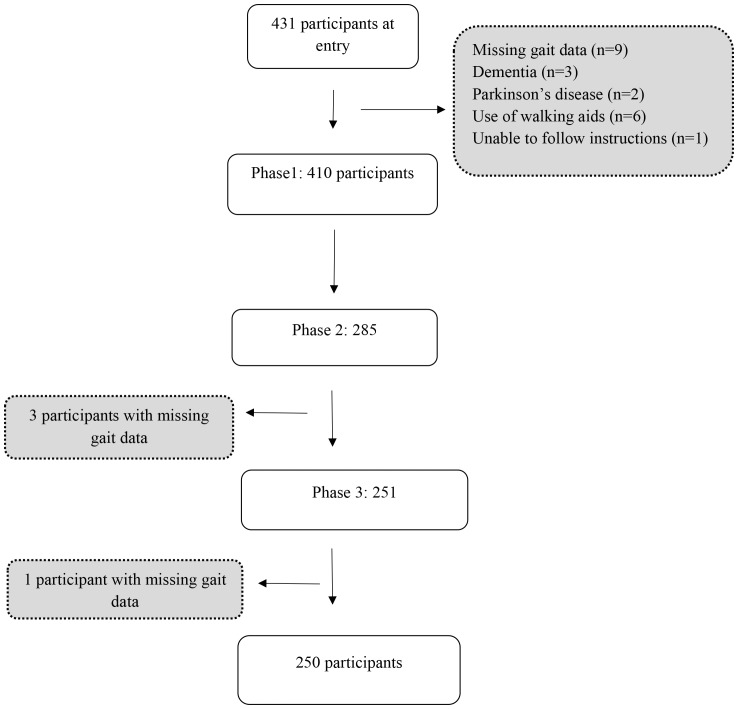
Study flow chart.